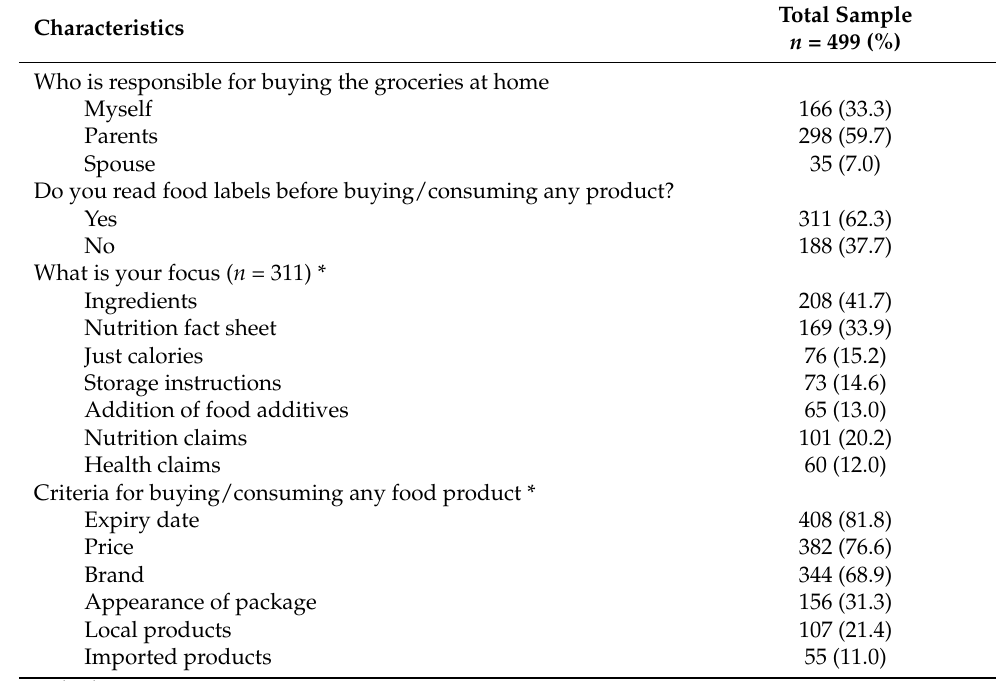
Table 5. Buying practices of the study